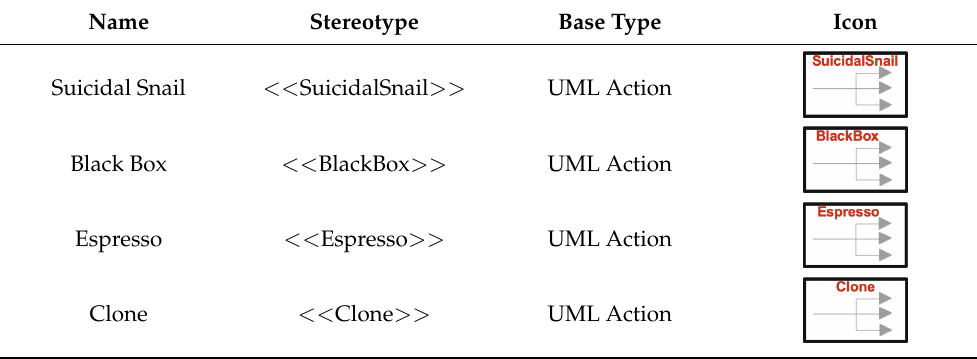
Table 7. Stereotypes for ZeroMQ specializations of the Publish–Subscribe Channel